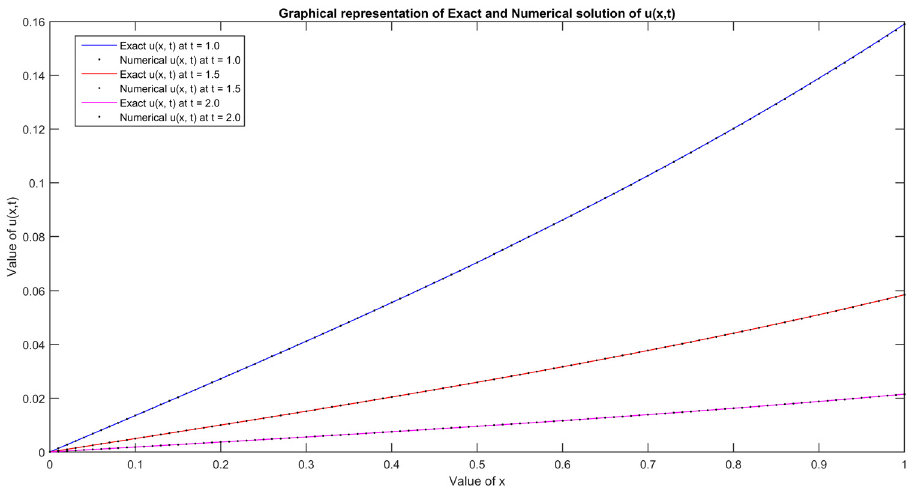
Figure 6: Comparison of ( ) u x t , at = t 1.0 , 1.5, and 2.0 for = N 101 , = α 30 , = β 10 , = t Δ 0.0001 , and = τ 0.5 using Method II regarding Example